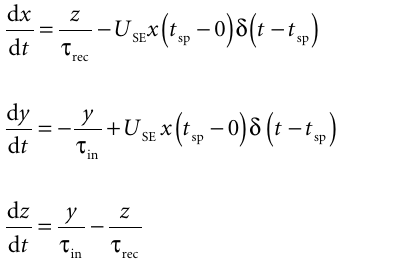
connections (Le Be and Markram, 2006). (C) Cluster of four cells viewed by infra-red differential interference contrast microscope. (Upper right) Neurons during fi rst patch. (Lower right) Neurons after 12 h of glutamate stimulation. (D) Mesh rendering on camera lucida of anatomical reconstructions of two neurons where a connection appeared after evoking with sodium glutamate. (Red Dots): Putative synaptic contact